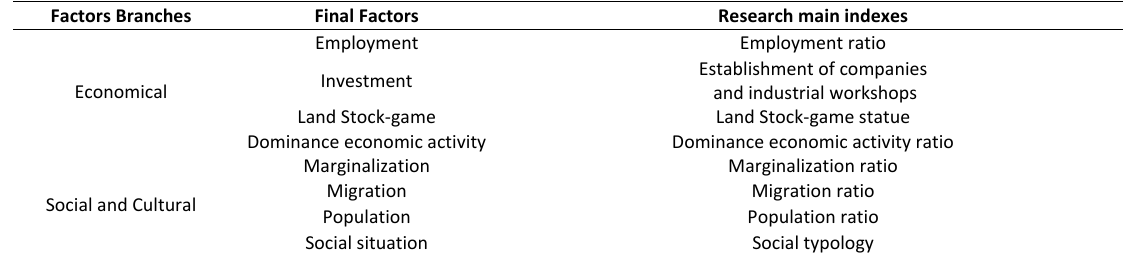
Table 6: Development of the main indicators of mechanisms affecting urban development, taking into account its sphere of